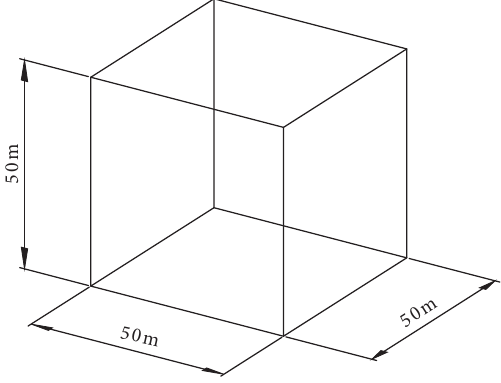
Figure 1: Dimensions of model